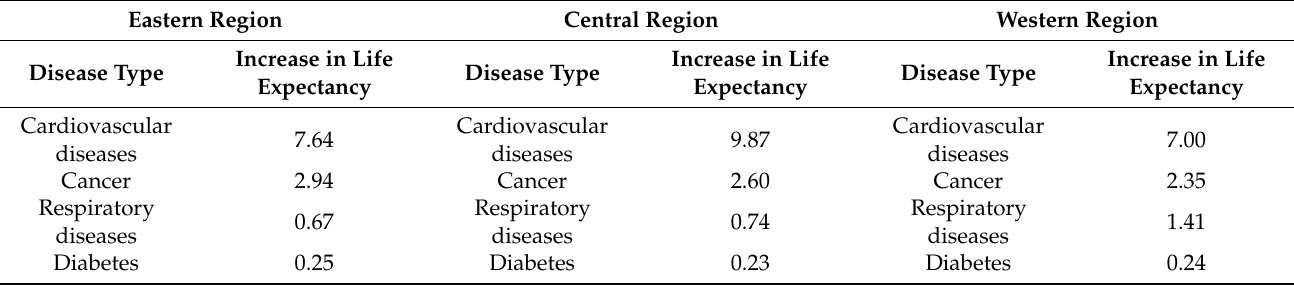
Table 3. Increases in life expectancy by region of residence after eliminating diseases’ deaths. China, 2019.